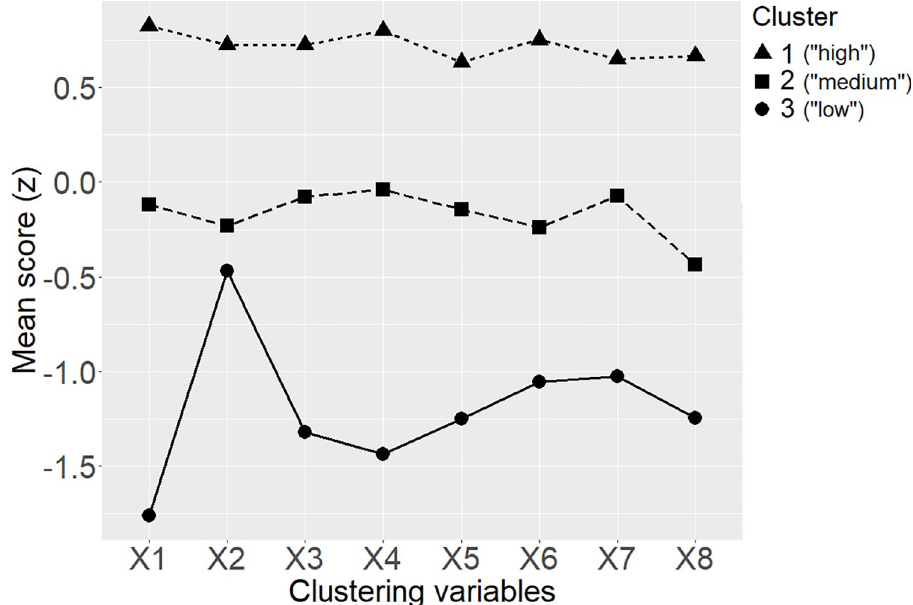
Fig 1. Example of the typical profiles of mean scores of clusters detected from a set of positively correlated variables. Clustering variables were correlated with r = 0.30, normally distributed, and without any true underlying sub-populations. Data was simulated with N = 200. Model-based Gaussian mixture clustering was performed, with BIC used for selecting optimal number of clusters (see Study 2 for details).